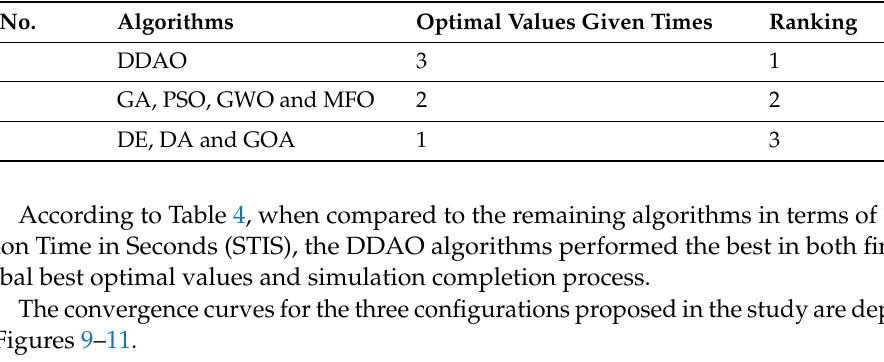
Figure 8. Energy output graph for different components of a Ni-Fe battery configuration over a year. Table 5. Rankings of algorithms in providing the optimal